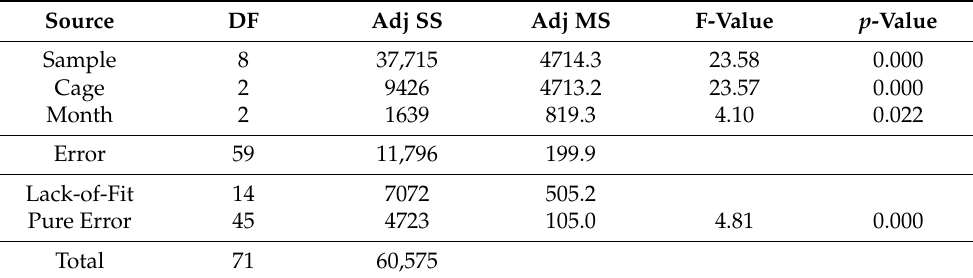
Table 4. Analysis of variance for the percentage of weight